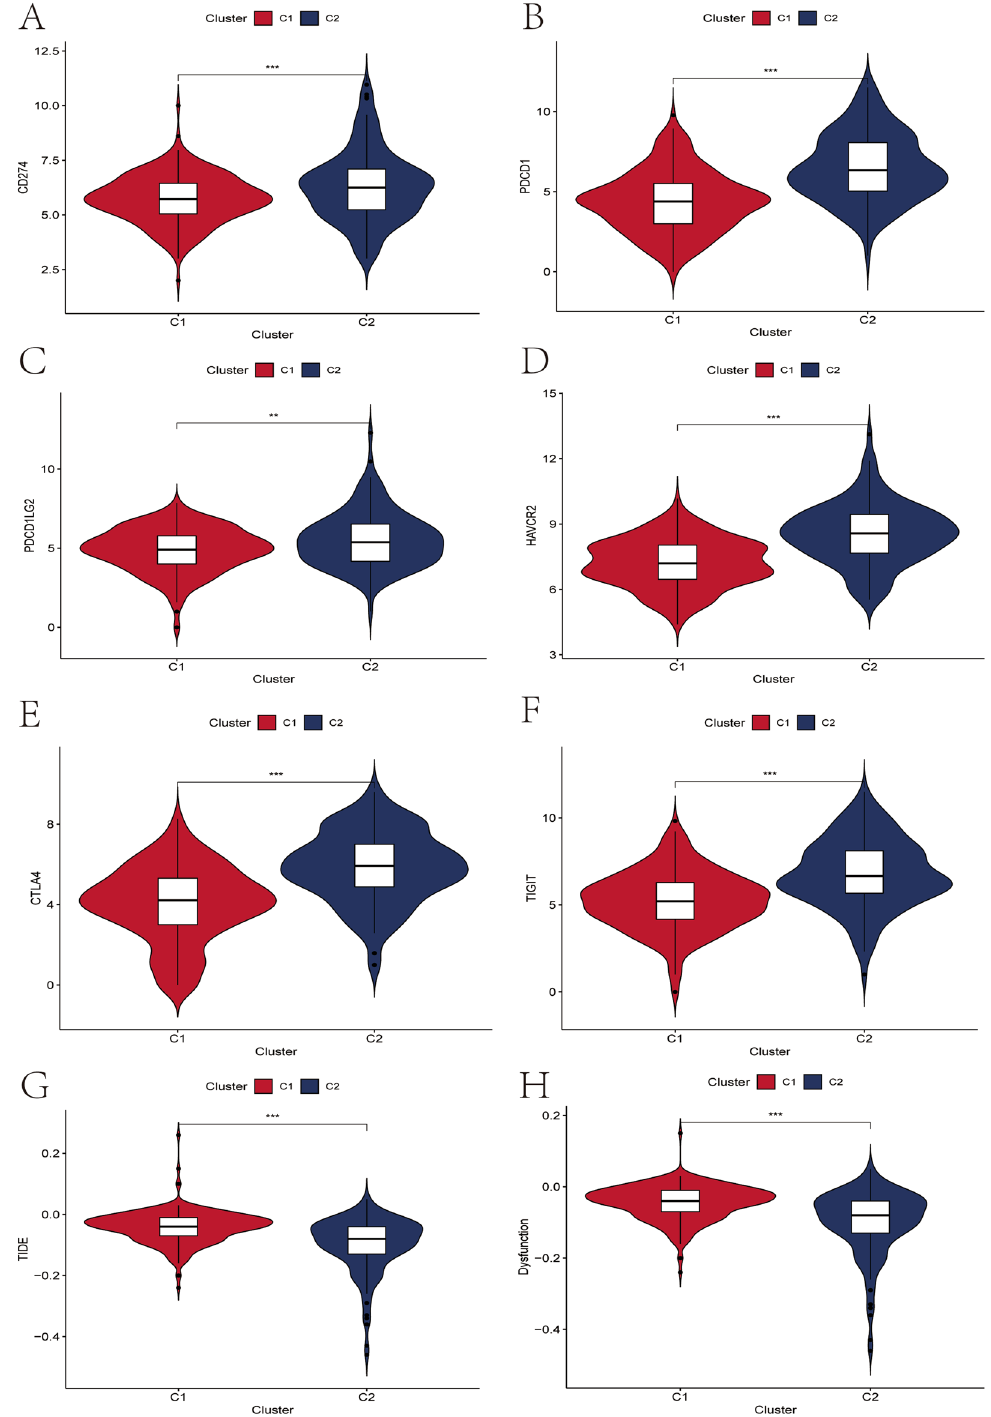
Figure 6. Relationship between mRNA expression levels of immune checkpoint-associated genes and different clusters. ( A – F ) Differences in mRNA expression levels of six immune check-related genes commonly used in HCC immunotherapy between C1 and C2, including PD-L1 ( A ), PD1 ( B ), PD-L2 ( C ), TIM-3 ( D ), CTLA4 ( E ) and TIGIT ( F ). (G-H) TIDE scores ( G ) and Dysfunction scores ( H ) were used to assess immunotherapy